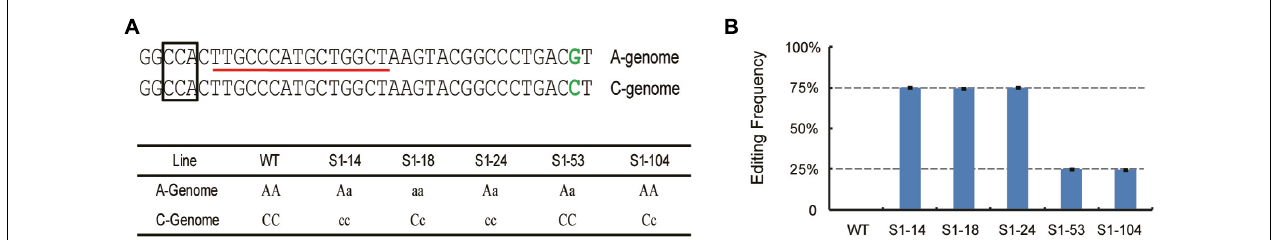
FIGURE 5 | Detection of the editing frequencies in allotetraploid rapeseed using droplet digital PCR. (A) The target sequences and genotypes at the target site of gene-edited rapeseeds. The box and red line indicate the PAM- and FAM-labeled probe, respectively. The green colors indicate the SNP differences between the Chr. A03 and C03 genome. (B) Detection of editing frequency of different rapeseed lines by